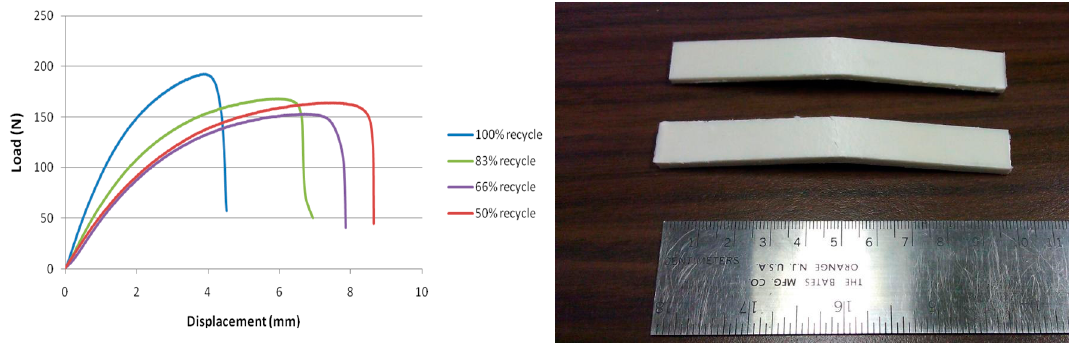
Table 4. Summary of flexure tests for various recycled fiber contents for ‘Longitudinal’ and ‘Trans- verse’, respectively.